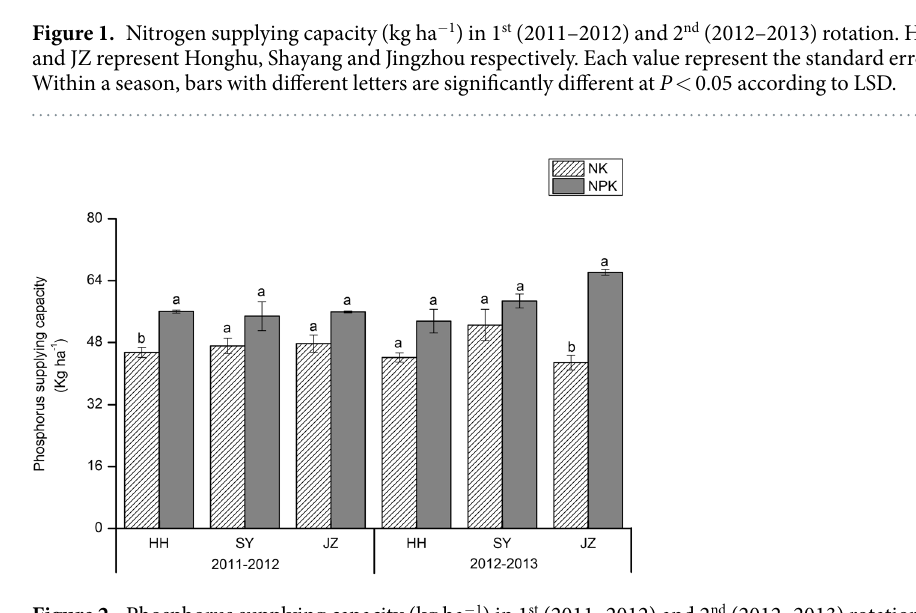
Figure 2. Phosphorus supplying capacity (kg ha − 1 ) in 1 st (2011–2012) and 2 nd (2012–2013) rotation. HH, SY and JZ represent Honghu, Shayang and Jingzhou respectively. Each value represent the standard error ( n = 3). Within a season, bars with different letters are significantly different at P < 0.05 according to